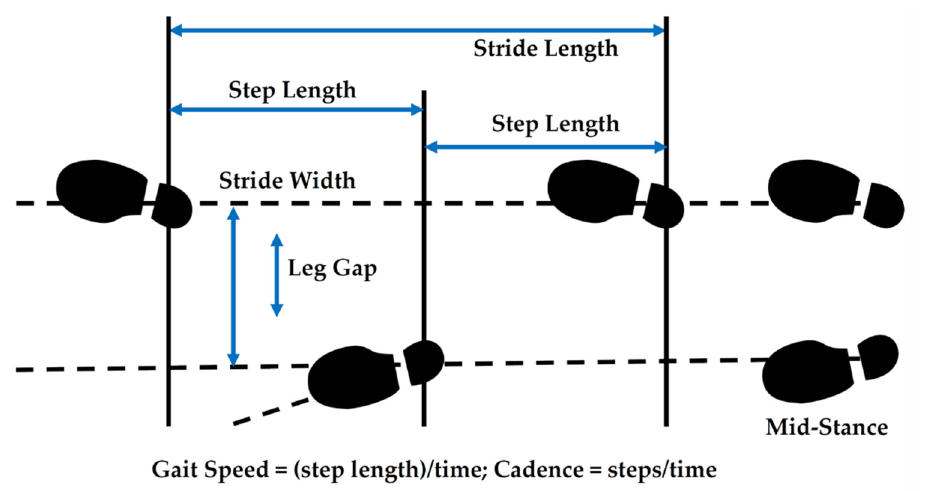
Figure 4. Gait Figure 4. Gait Parameters. Table 5. Descriptive Statistics and Normality of Leg Gap Data.